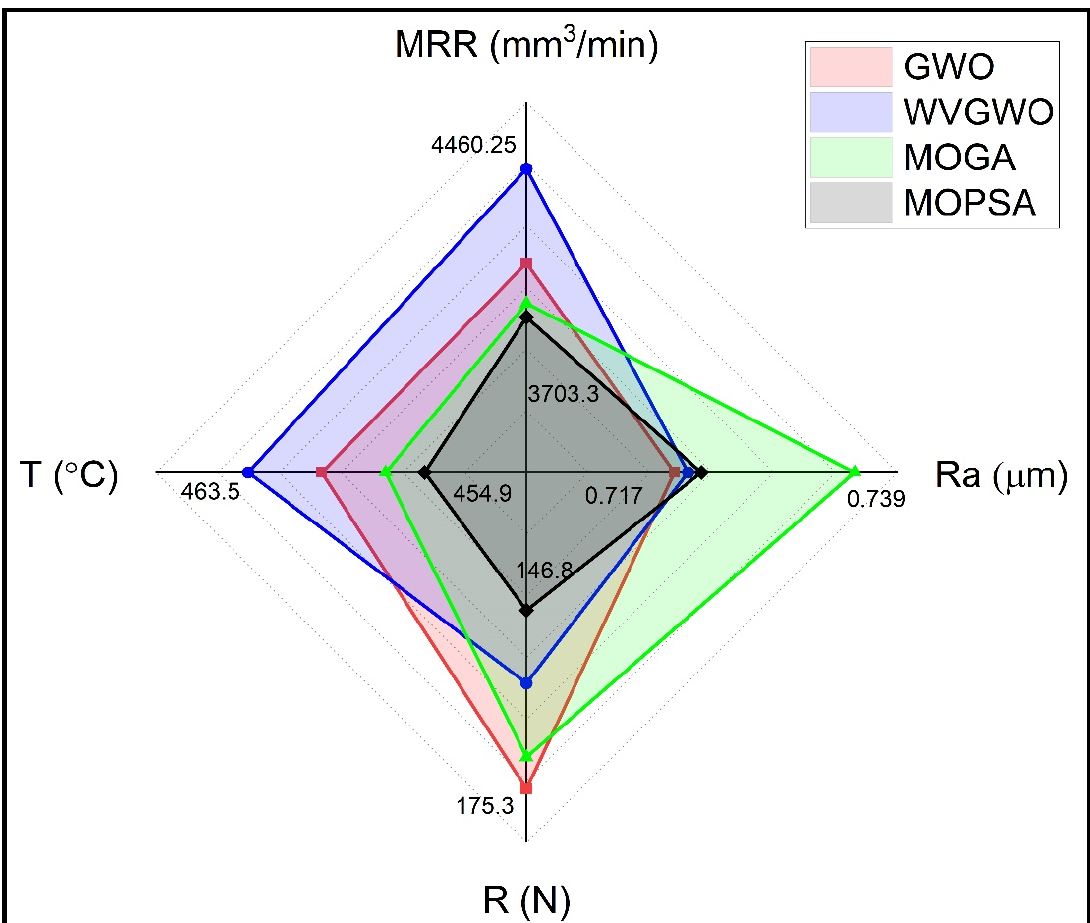
Figure 14. Comparison between the optimal results obtained by the four different algorithms used.